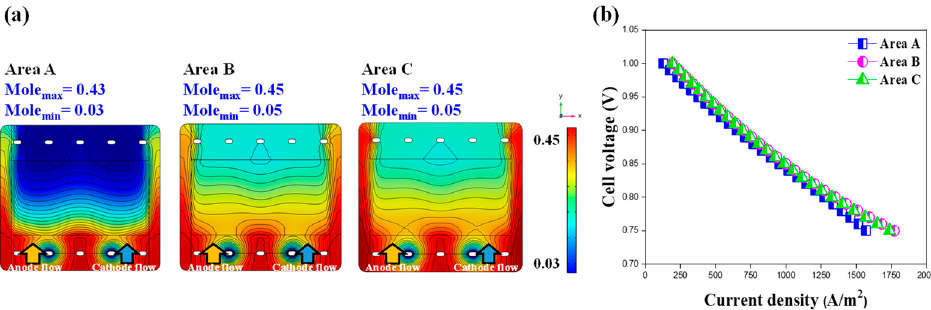
Figure 16. ( a ) Hydrogen distribution and ( b ) i–V curve, according to the reforming